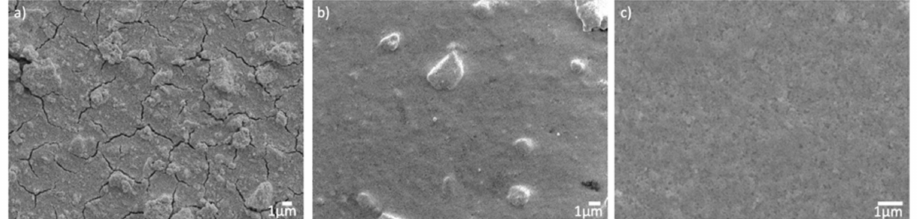
Figure 10. Scanning electron micrographs of the HfO 2-EPD films prepared by electrophoretic deposi- tion of colloidal suspensions of HfO 2-NPs in ( a ) acetone, ( b ) ethanol or ( c ) an equimolar mixture of ethanol and acetylacetone.